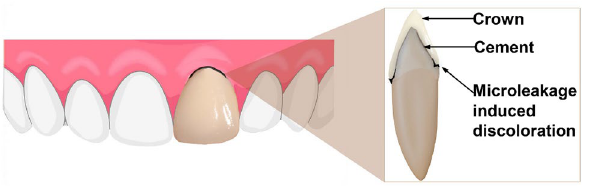
Figure 1. Schematic representation of luting cement failure leading to discoloration, loss of esthetics, and secondary carious